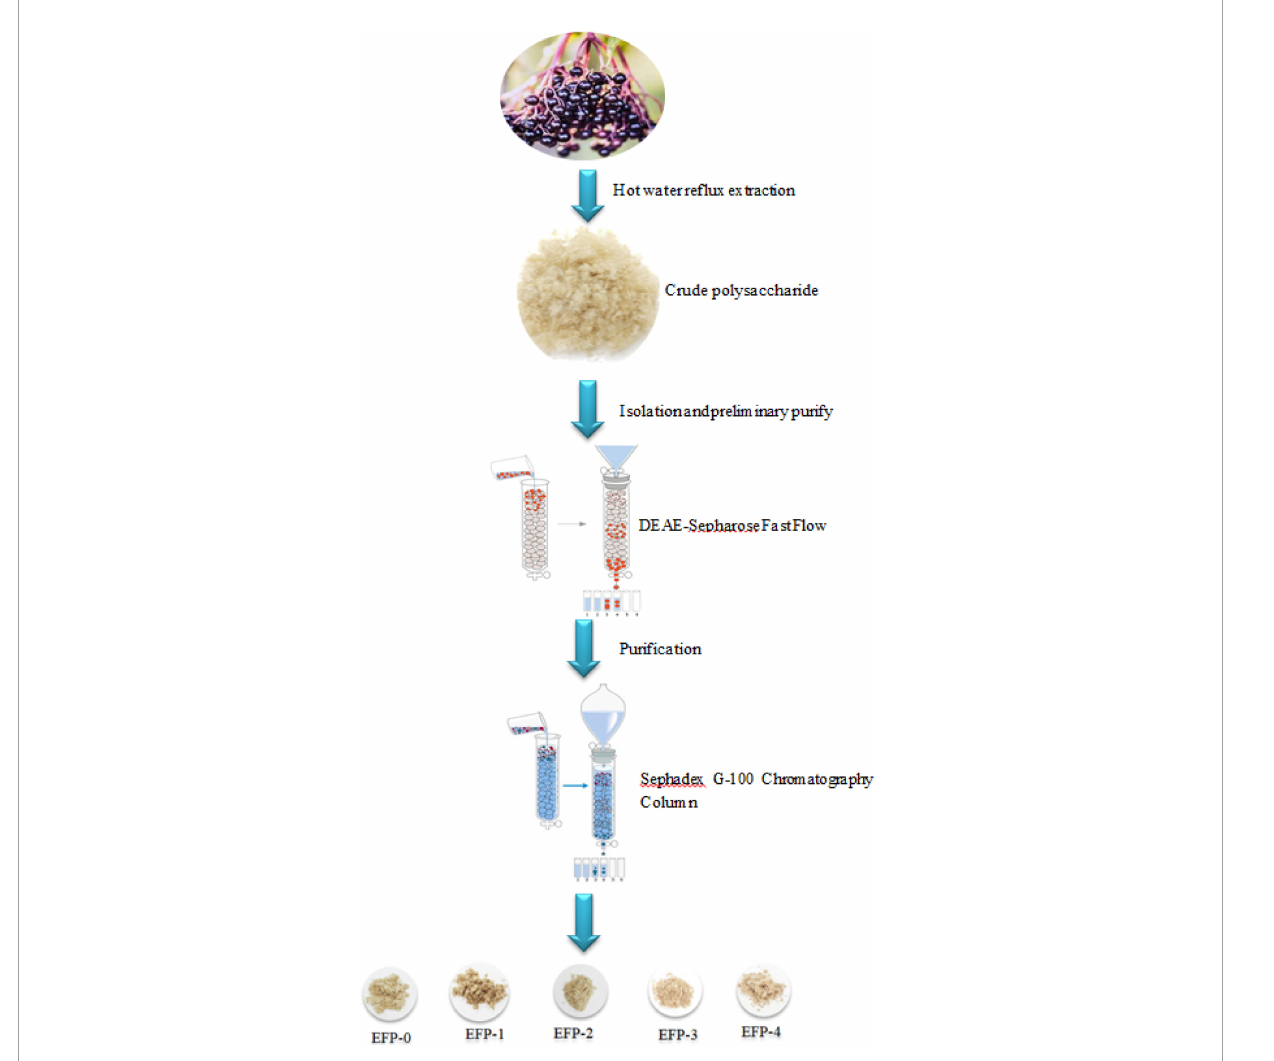
FIGURE1 Flow chart of elderberry polysaccharide extraction, separation, and